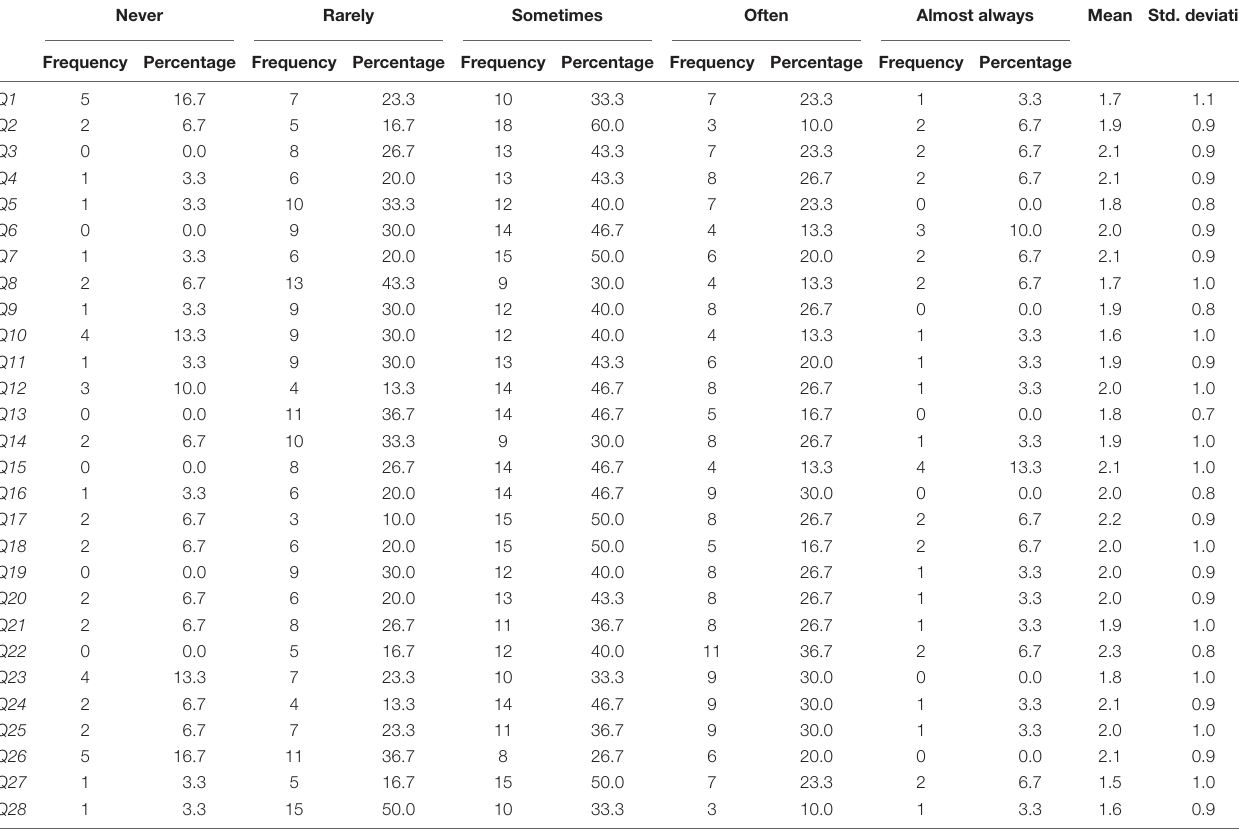
TABLE 3 | Distribution of the responses of the control group to the questionnaire after treatment. Never Rarely Sometimes Often Almost always Mean Std.